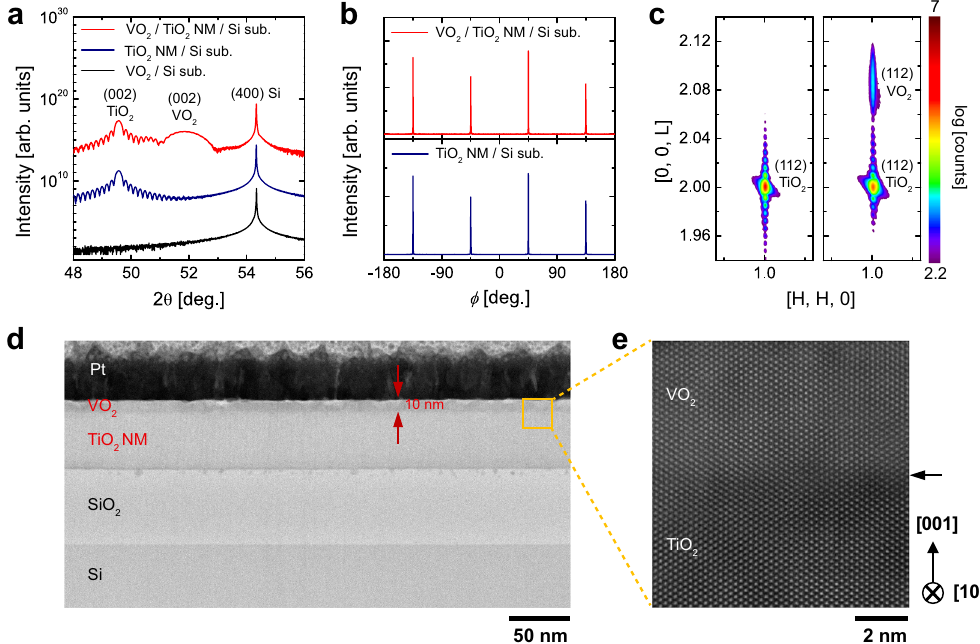
Fig. 4 Heterogeneous integration of rutile oxide epitaxial VO 2 /TiO 2 heterostructures on Si substrates. a Symmetric 2 θ (cid:3) ω scan, b asymmetric ϕ scan, and c reciprocal space mapping around (112) re fl ection of TiO 2 NM on Si substrates before (blue in a , b , and left in c ) and after (red in a , b , and right in c ) the growth of VO 2 fi lms, implying single-crystallinity of coherently strained VO 2 fi lms on TiO 2 NM/Si. d The cross-sectional ABF-STEM images of the heterogeneous VO 2 /TiO 2 NM on SiO 2 /Si. The atomic-scale HAADF-STEM image at the area indicated by the yellow square in d is shown in e (zone axis: [100] in TiO 2